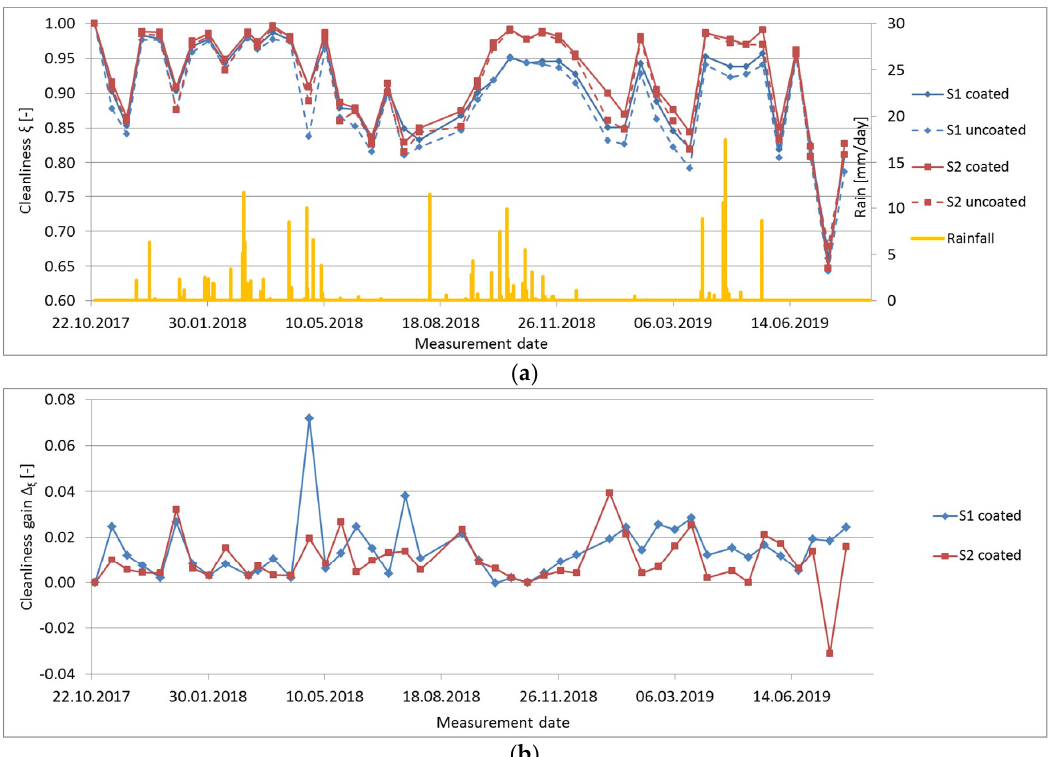
Figure 2. Data before cleaning, ( a ): cleanliness factor, ( b ): cleanliness gain.